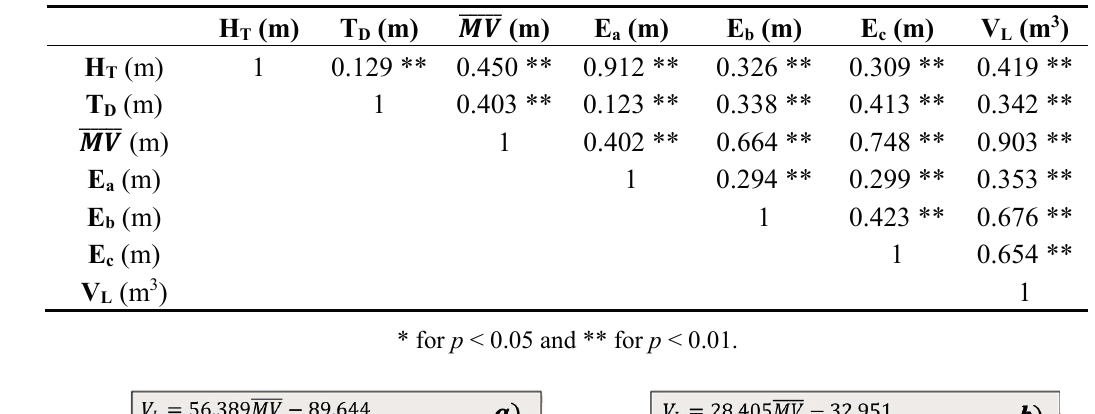
Table 4. Multiple correlations between different parameters obtained in the study for all the tree types.